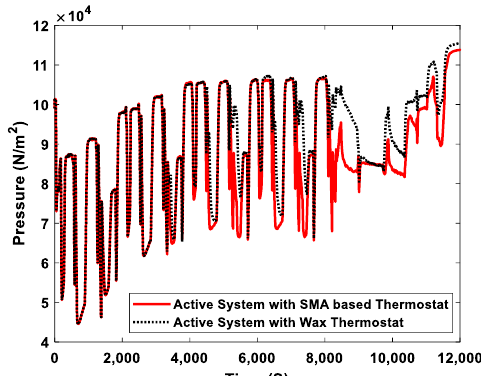
Figure 13. Engine coolant pressure for the active engine cooling system with an SMA-based ther- mostat and a wax thermostat. stat and a wax